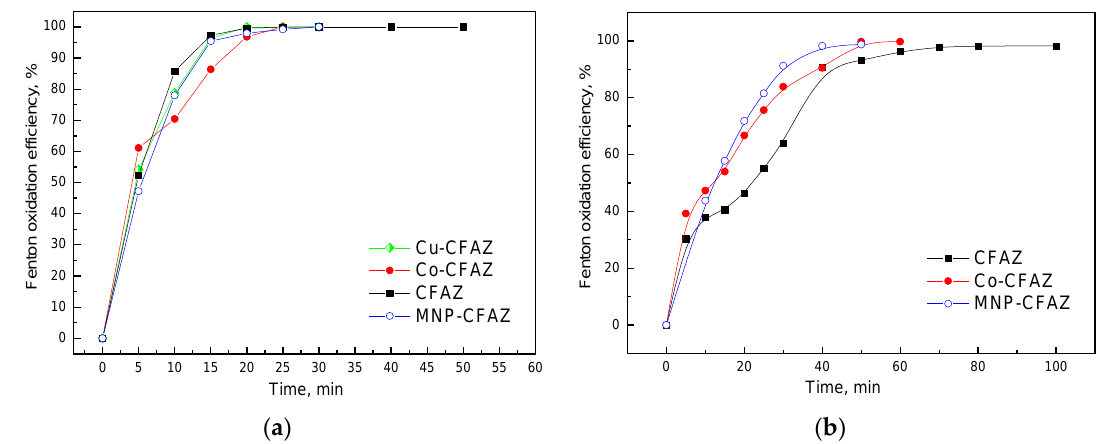
Figure 9. Fenton oxidation of MB in the presence of CFAZ and modified CFAZ: ( a ) kinetic curves at 90 °C; ( b ) kinetic curves at 60 °C. Table 4. Kinetic constants and oxidation reaction half-life of the Fenton oxidation process of methylene blue onto nonmodified and metal oxide modified CFAZs.